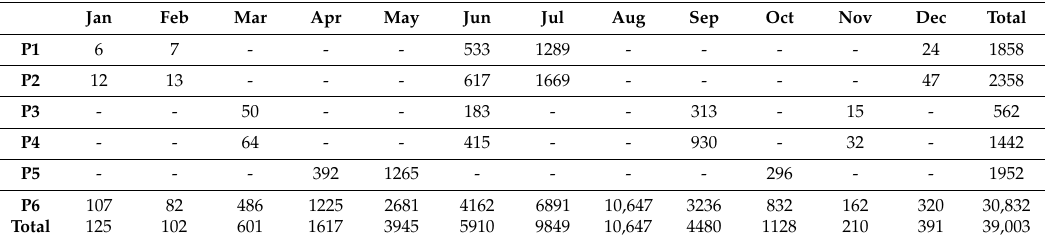
Table 5. Distribution of the electrical demand of the system with intraday management of the hourly demand